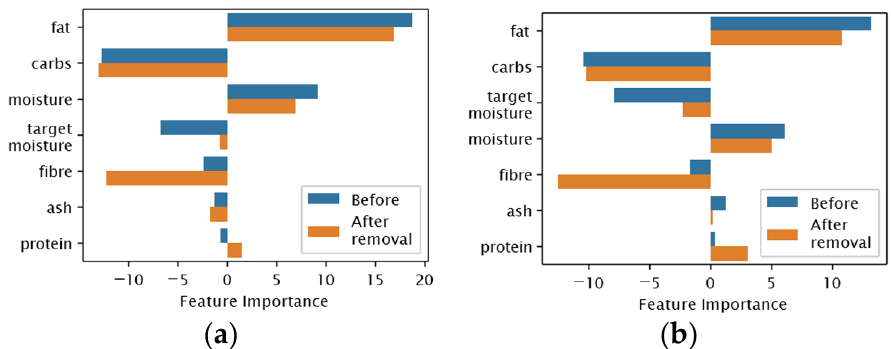
Figure 7. Feature importance scores of Ridge after removal of FBC-com. ( a ) Scores for Hardness; ( b ) Scores for Chewiness.